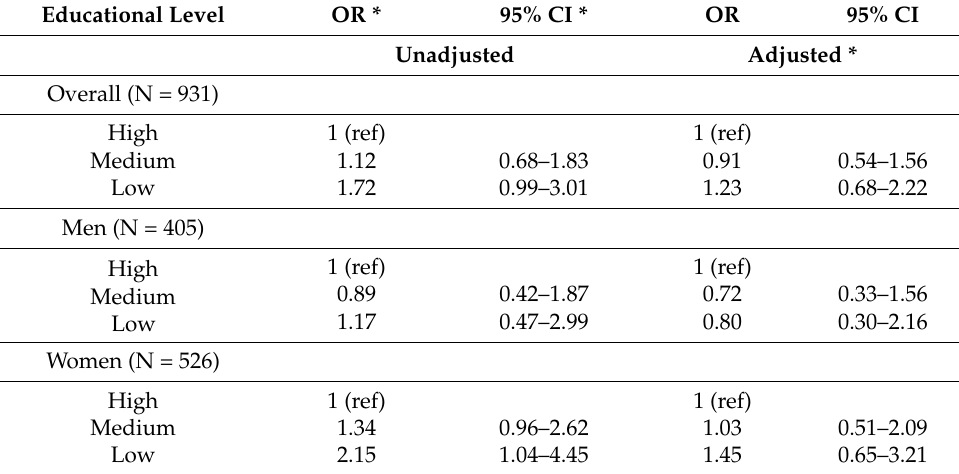
Table 3. Association between educational level and worsening in diet quality among adults in Madrid from 2017 to